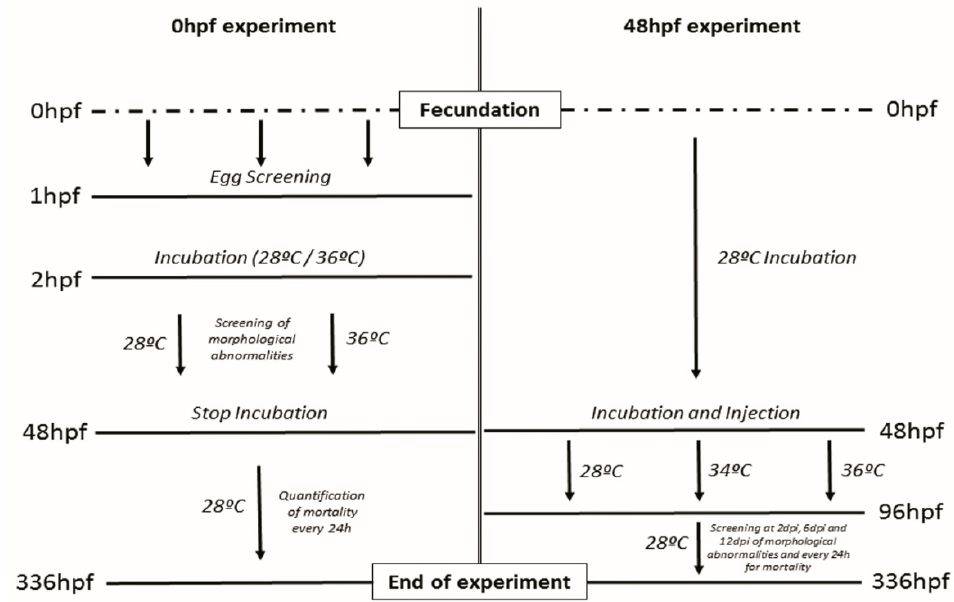
Figure 1. Overview of the two assays starting at two different start points. Hpf = hours post-fertilization. Dpi = days post- injection.